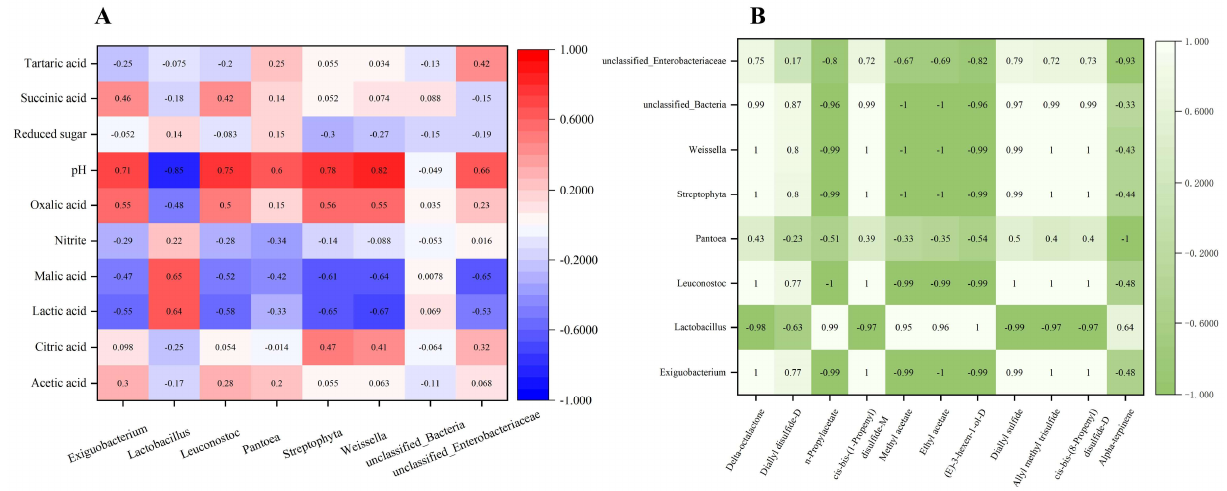
Figure 9. The correlation heatmap between bacteria genera and chemical compounds ( A ); between bacteria genera and VOCs ( B ) of the fermented pickles.